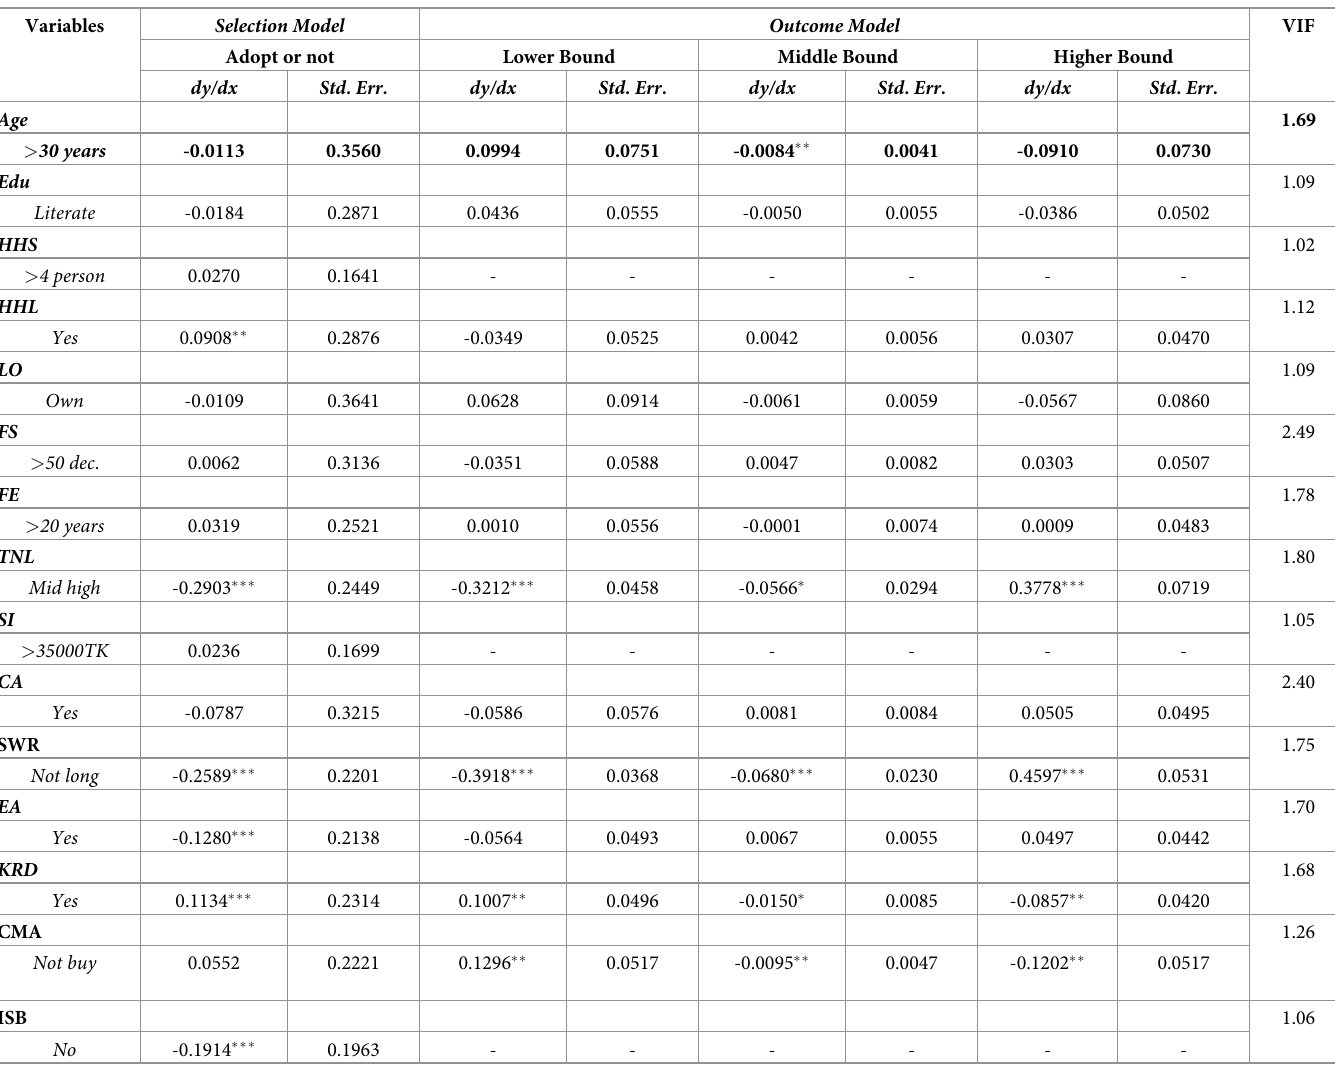
Table 3. The ordered probit model with sample